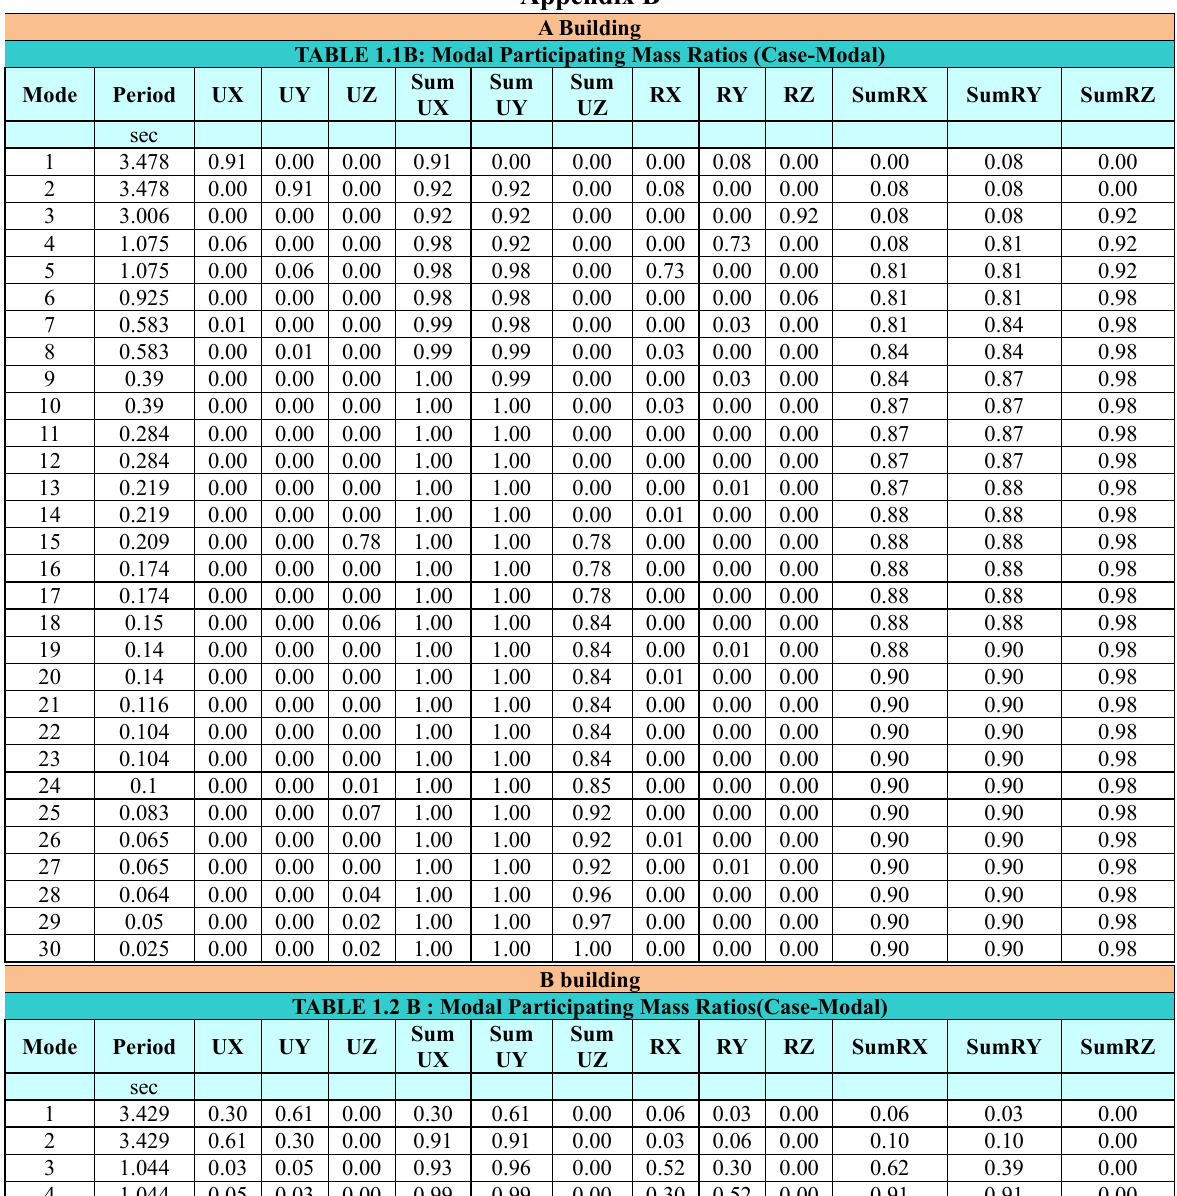
TABLE 1.1B: Modal Participating Mass Ratios (Case-Modal)